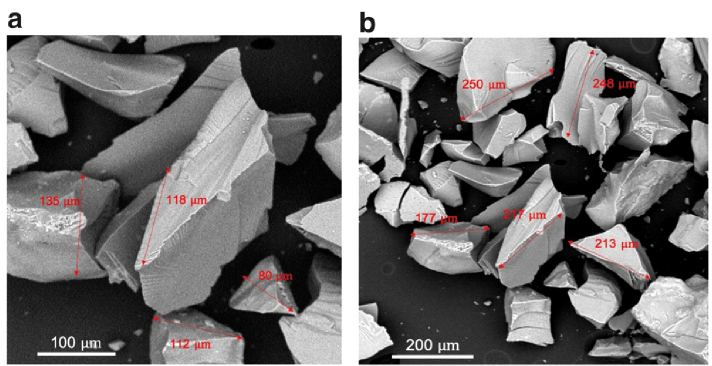
Figure 4. Scanning electron micrographs of silica xerogel from corn husk.